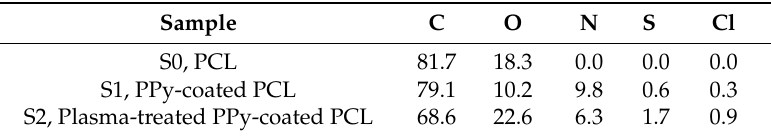
Table 1. Elemental composition of the samples by percentages.